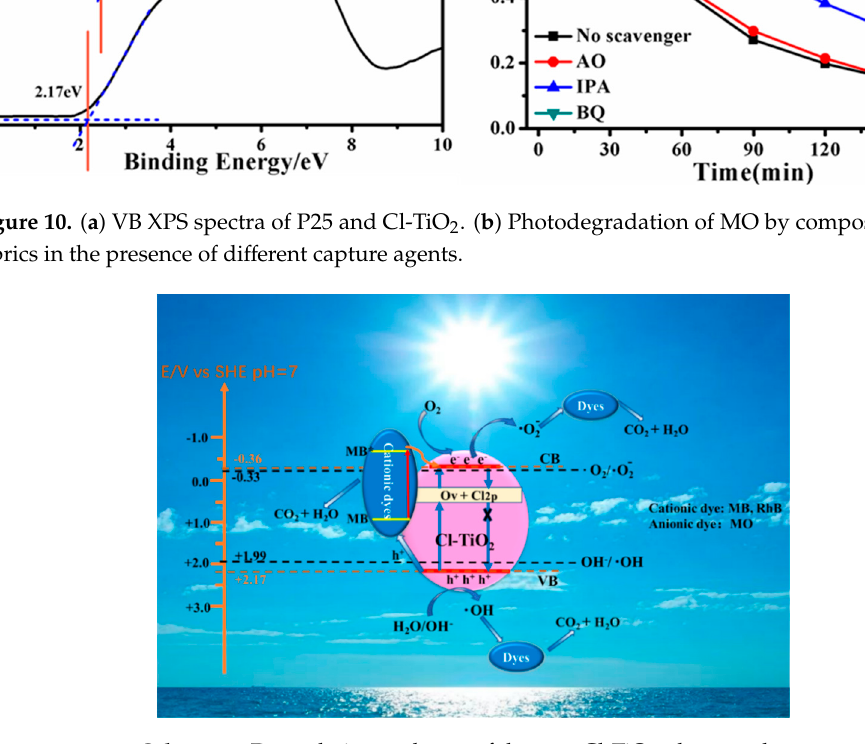
Scheme 2. Degradation pathway of dyes on Cl-TiO 2